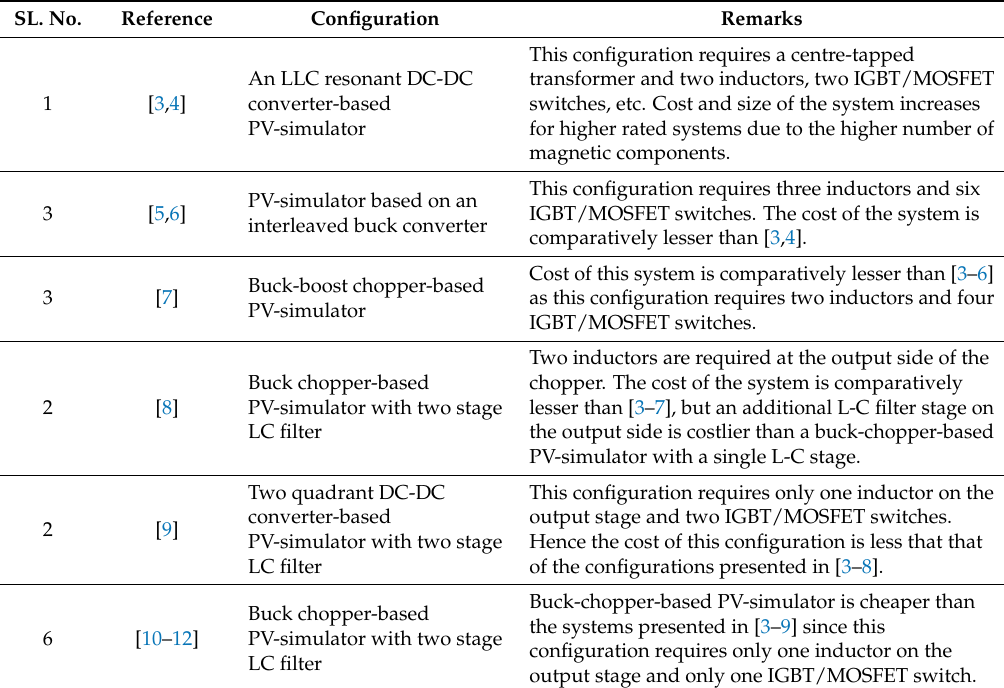
Table 1. Parameters of Selected PV-array to Be